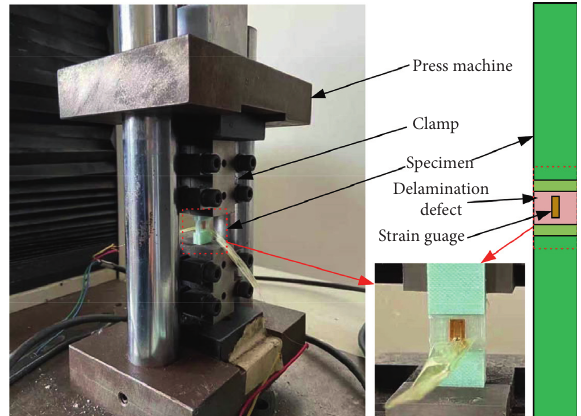
Figure 10: Fixation of the specimen.